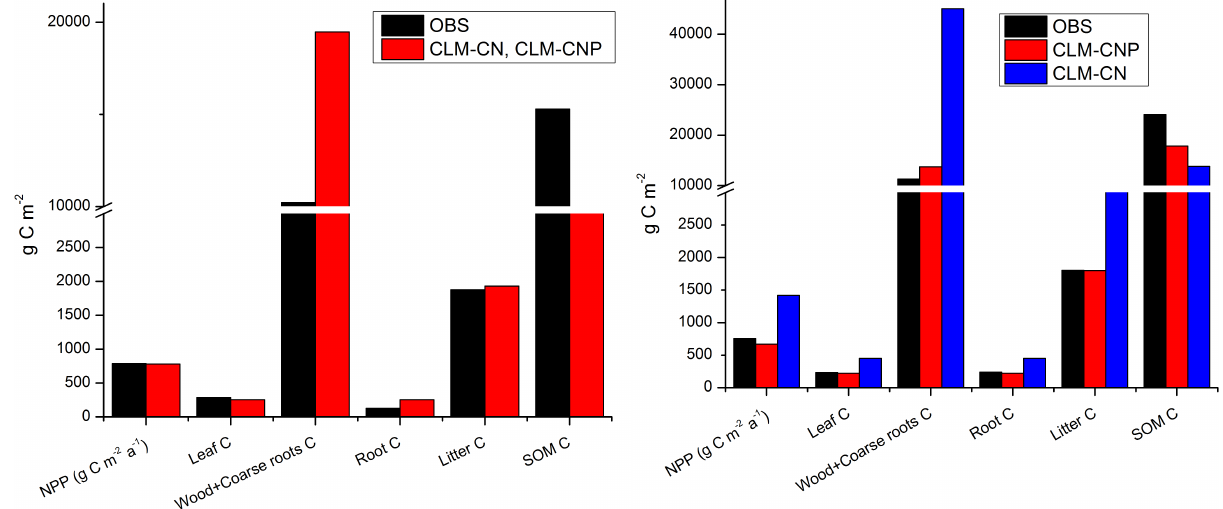
Fig. 2. Comparison between model simulations (CLM-CNP and CLM-CN) and the observations at the (a) N-limited site, and (b) P-limited